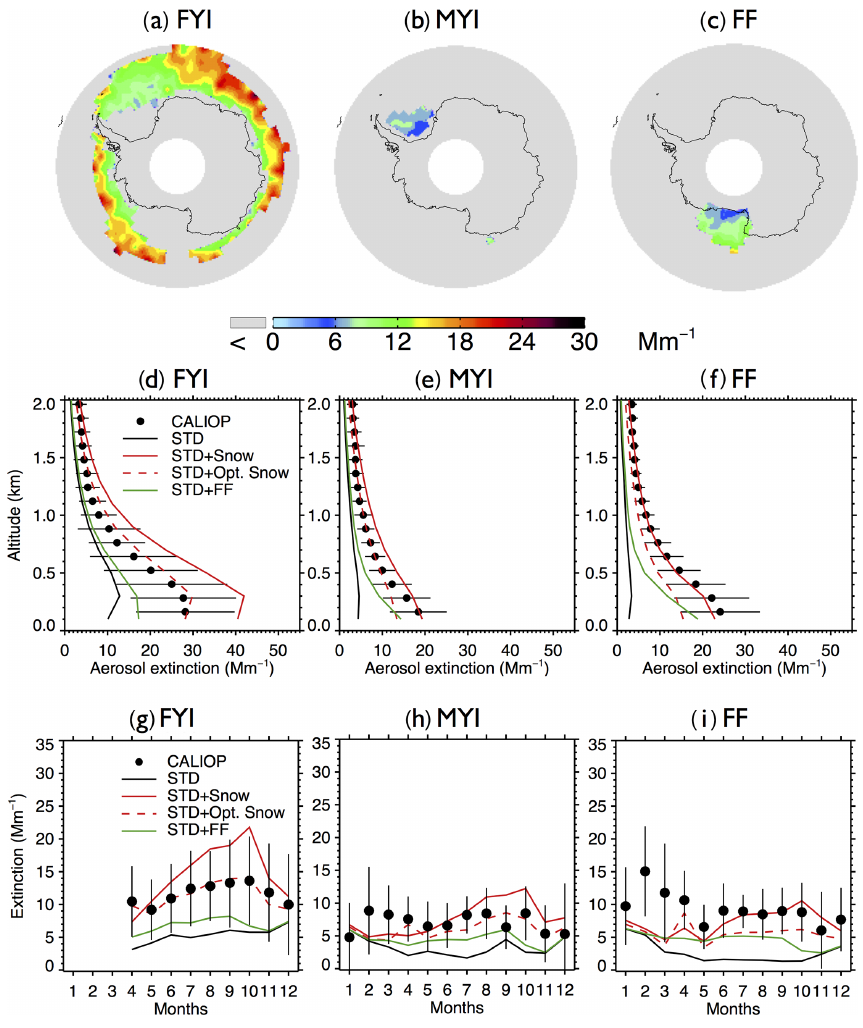
Figure 5. Same as Fig. 3, but for Antarctic aerosol extinction coefficients during austral winter (May–October) over (a) FYI (excluding offshore Ross Ice Shelf), (b) MYI, and (c) offshore Ross Ice Shelf. As shown in (g) , the monthly average aerosol extinction coefficients are not available over FYI during Antarctic summer (January–March) due to the limited FYI